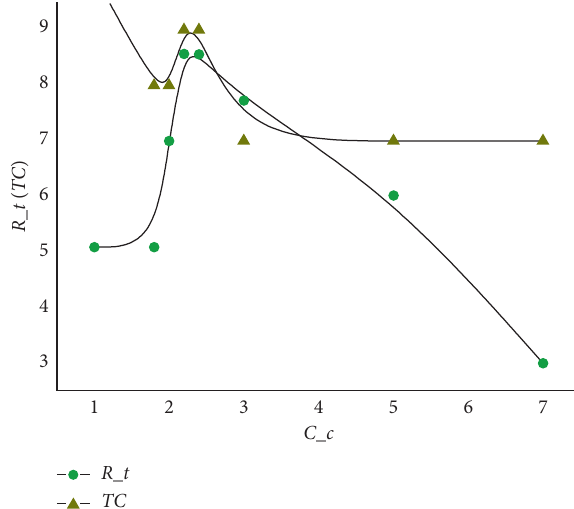
Figure 9: Diagram of rework time and number of communication changes with different communication costs.